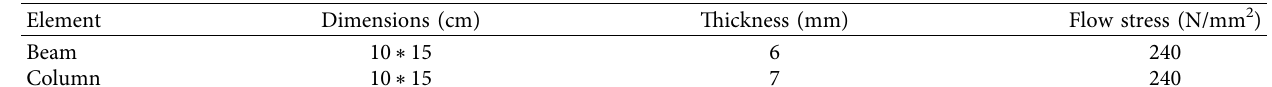
Figure 6: Nonlinear behavioral model of steel [20]. Table 2: The geometric characteristics of beams and columns.